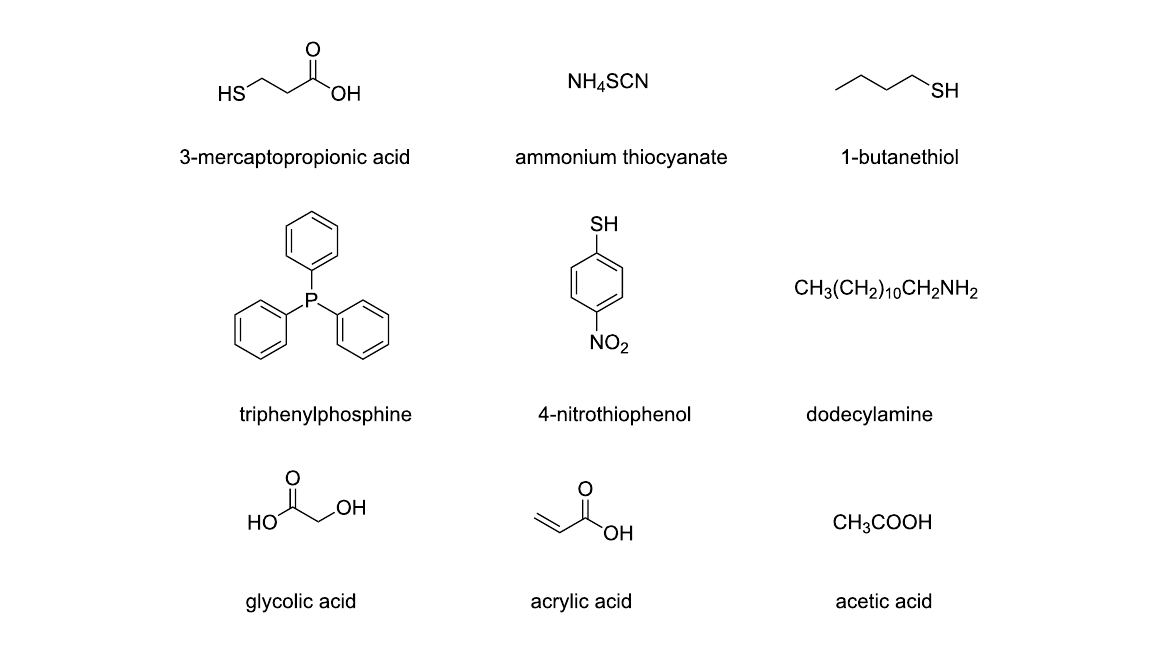
Figure 3: Representative examples of surface ligands that have been shown to improve charge transport properties in